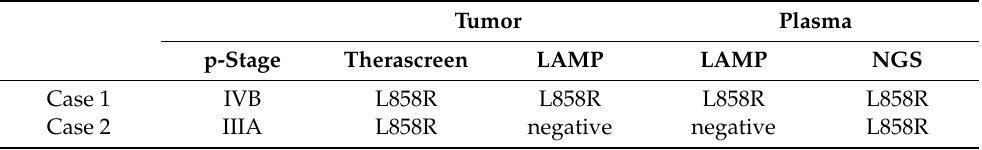
Table 3. Comparison of EGFR status between resected tumor and preoperative plasma samples.